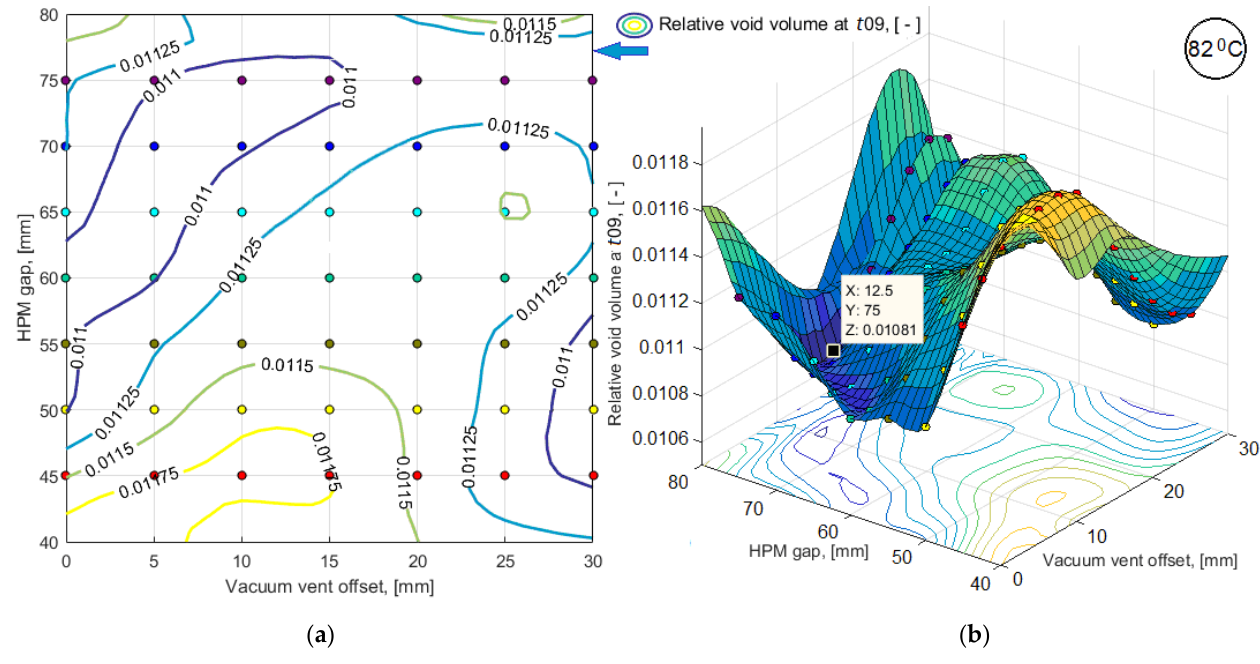
  09 tV response in the form of: ( a )   09 tV v response in the form of: ( a ) v